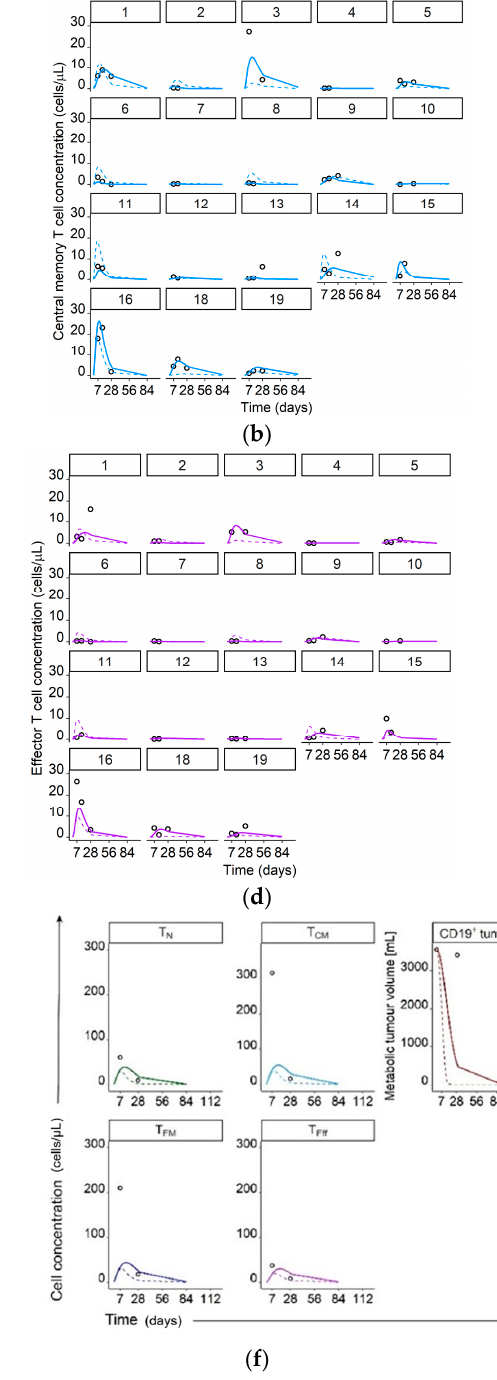
Figure 3. Figure 3. Measured T cell concentrations/metabolic tumor volumes (data points) and simulated typical (dashed lines) and individual (solid lines) model predictions for individual patients 1–16, and 18–19 in panels a–e and, as concentra- tions/volumes of all species were significantly higher, for patient 17 in separate panel ( f ). Legend: ( a ) Naïve CAR-T cells; ( b ) Central memory CAR-T cells; ( c ) Effector memory CAR-T cells; ( d ) Effector CAR-T cells; ( e ) CD19 + metabolic tumor volume; ( f ) Concentrations of naive, central memory, effector memory, and effector CAR-T cells as well as CD19 + metabolic tumor volume for patient 17. Abbreviations—T N : naïve CAR-T cells, T CM : central memory CAR-T cells, T EM : effector memory CAR-T cells, T Eff : effector CAR-T cells, CD19 + tumor: CD19 + metabolic tumor